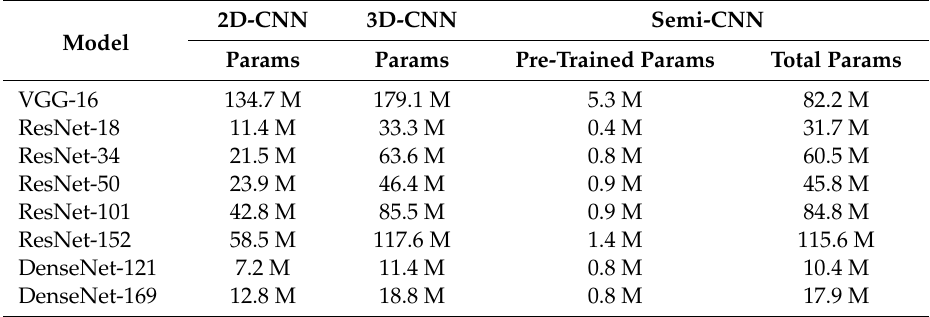
Table 2. Number of training parameters in millions(M) for VGG, ResNet and DenseNet models.